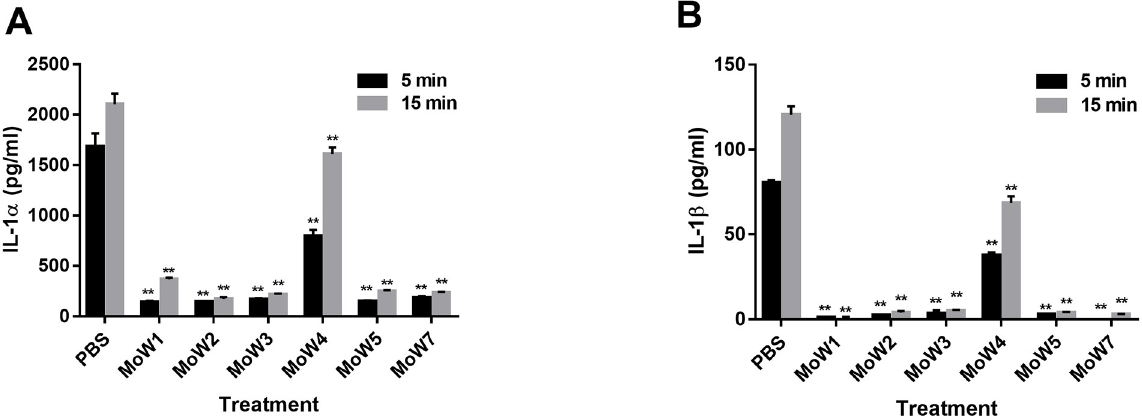
Fig 2. Induction of proinflammatory cytokines secretion by TR146 cells infected with MoWs-treated C . albicans . Yeast cells, treated for 5 minutes (black columns) or 15 minutes (grey columns) with MoWs or PBS (as negative control), were washed, suspended in cF12 and seeded (1 x 10 5 cells/well) in 96-well plates containing a 3 days old monolayer of TR146 cells. After 24 hours incubation at 37˚C, supernatants were collected and cytokines/chemokines levels were assessed by an antibody microarray. Levels of IL-1 α ( A ) and IL-1 β ( B ) are shown. The results are mean values ± standard errors of triplicates. �� p < 0.001 indicate significant differences between MoWs-treated vs PBS-treated Candida . MoW1: Curasept 0.20; MoW2: Dentosan Collutorio; MoW3: Meridol Collutorio; MoW4: Elmex Sensitive Professional; MoW5: Listerine Total Care Zero; MoW7: